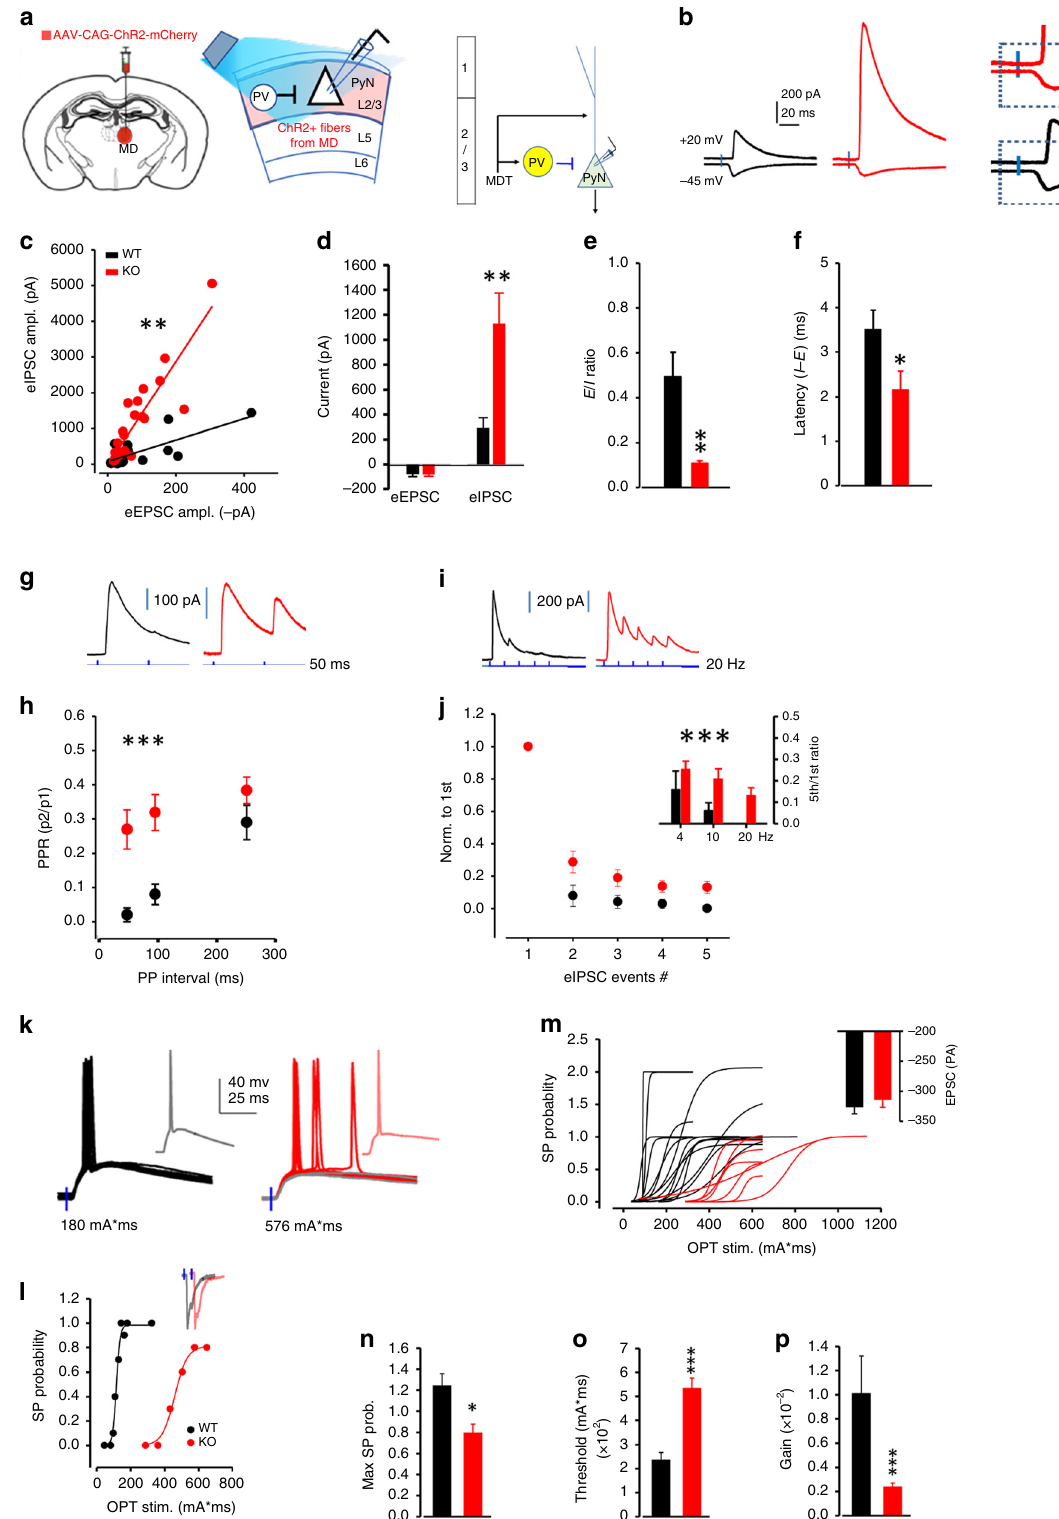
probability and plasticity with layer 5 electrical stimulation also changed in an opposite direction to that observed for PV- mediated inhibition in PV- Lmo4 KO mice (compare Fig. 5g, h to Fig. 4h, i). Intriguingly, these L5 inhibitory inputs were neither sensitive to DAMGO (a mu-opioid receptor agonist that inhibits GABA synaptic release from PV interneurons and